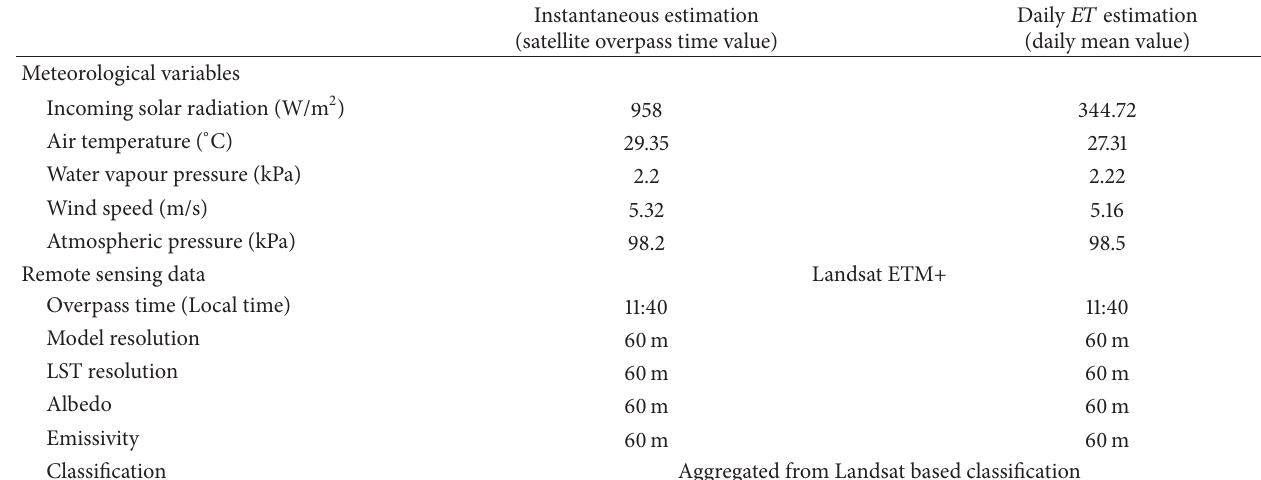
Table 1: Meteorological data and remote sensing data used in this study.